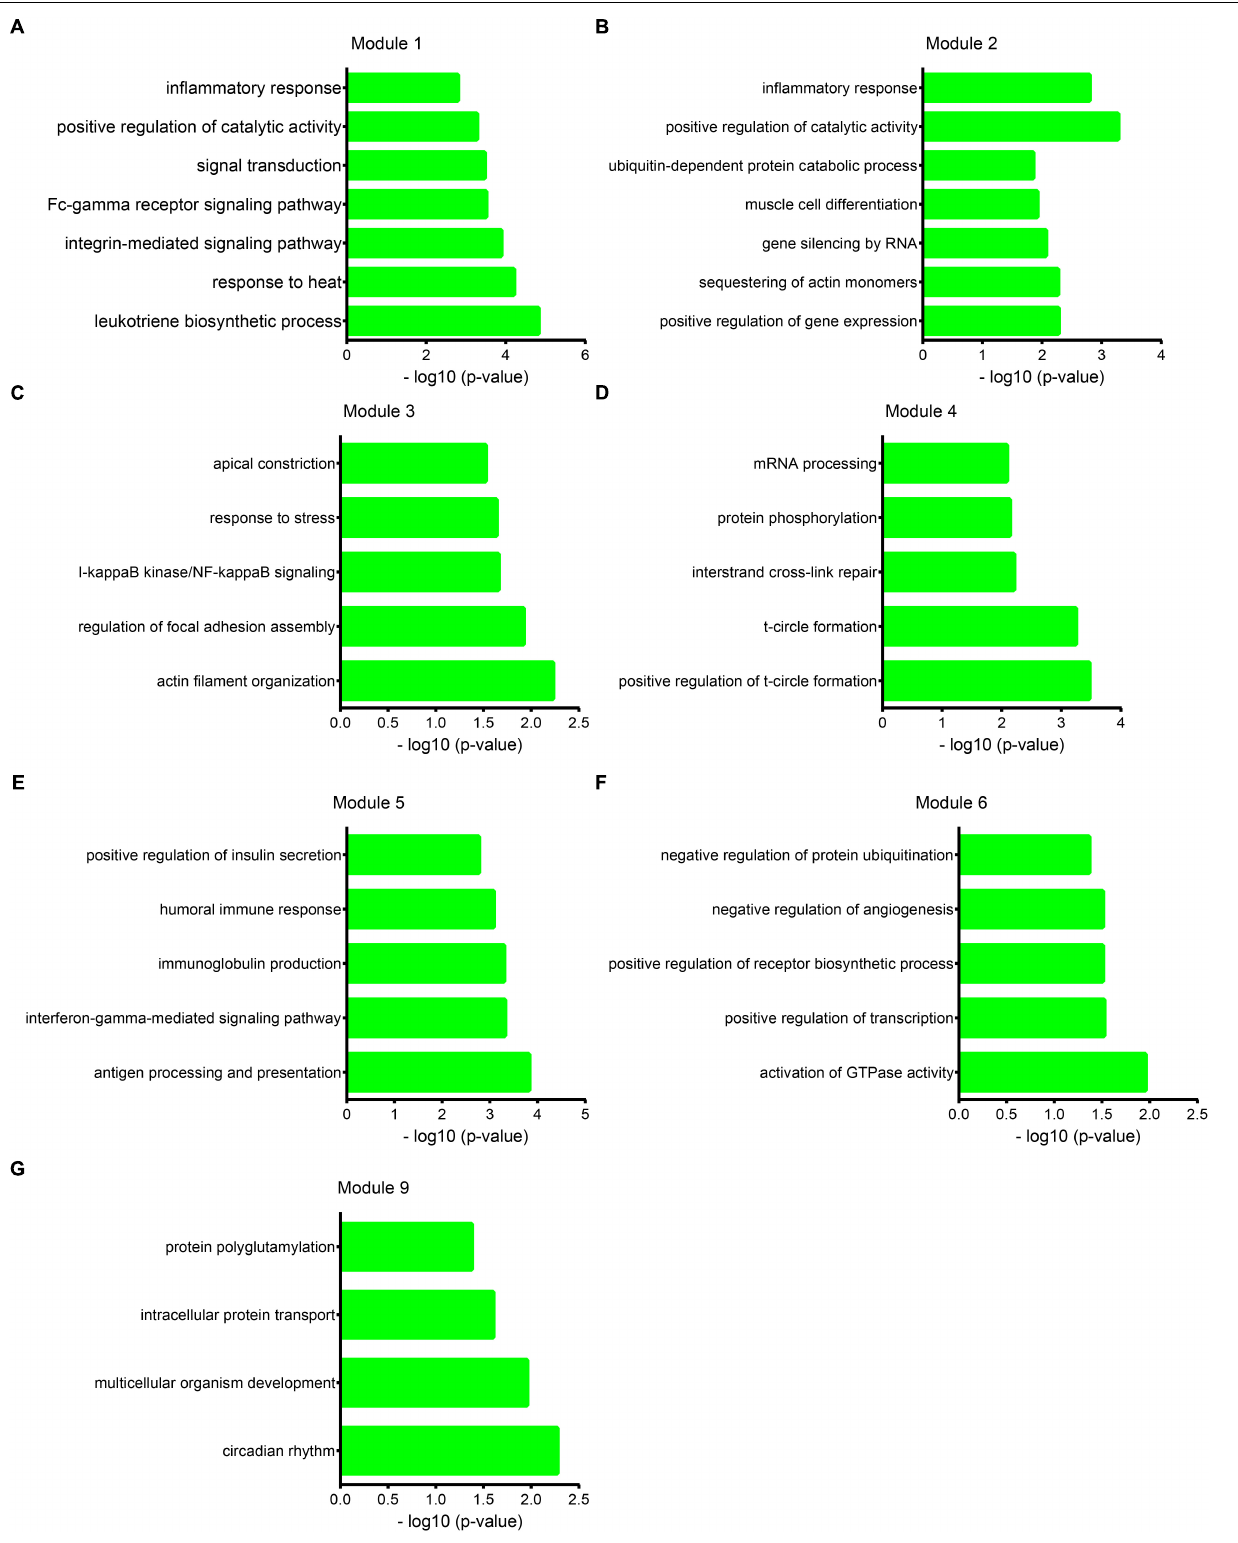
Frontiers in Genetics |